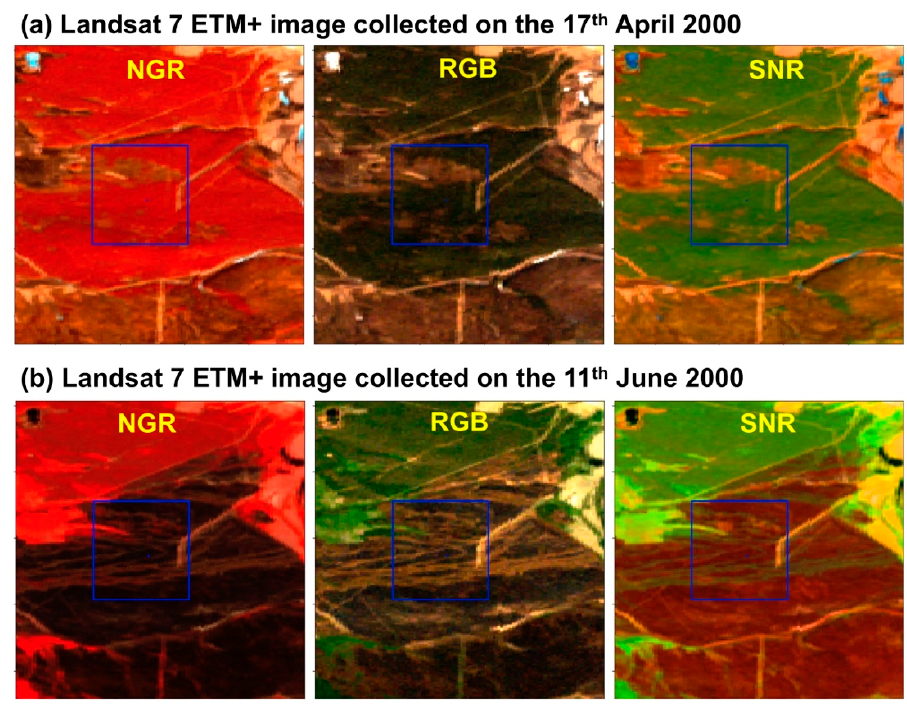
Figure 4. Example of a 2000 burn at site SP1 and a stand-replacing fire event was identified as occurring in April/May 2000. Here, we show Landsat-7 ETM+ images that were collected on the ( a ) 17 April 2000 and on ( b ) 11 June 2000. NGR is a near-infrared, red, green false-color image. RGB is the true-color image and SNR is the shortwave infrared, near-infrared, red false-color image. The blue box is a 1 × 1 km area around the site.